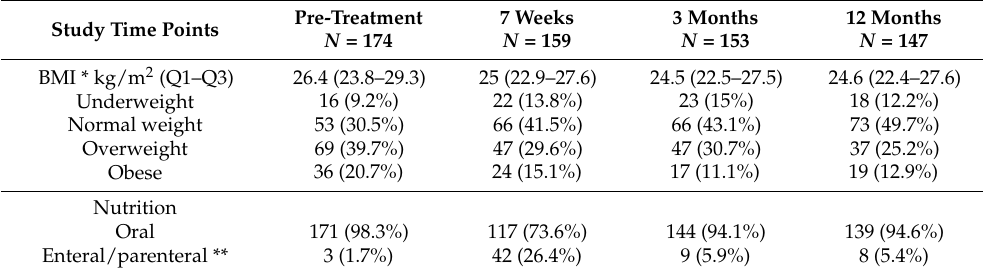
Table 2. Body mass index (BMI) and nutritional parameters of the study cohort ( n =